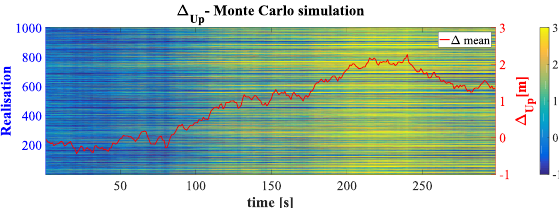
Figure 12. Variations in Up direction. Vehicle 1 - Sensor setup